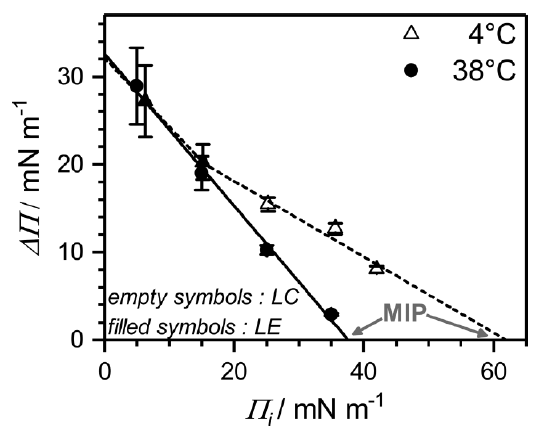
Figure 15. Results related to the surface pressure-time adsorption kinetics shown in Figure 14. The figure shows the insertion pressure ( ∆Π = Π eq − Π i ) upon β -aescin incorporation into a DMPC monolayer as a function of initial pressure Π i obtained from Π ( t ) adsorption kinetics. The temperatures investigated are 4 ◦ C (triangles) and 38 ◦ C (dots). Filled symbols: LE phase; open symbols: LC phase. MIP (grey) denotes the maximum insertion pressure (MIP) at ∆Π = 0. Reproduced with permission from Sreij et al. [46], ©2017 American Chemical